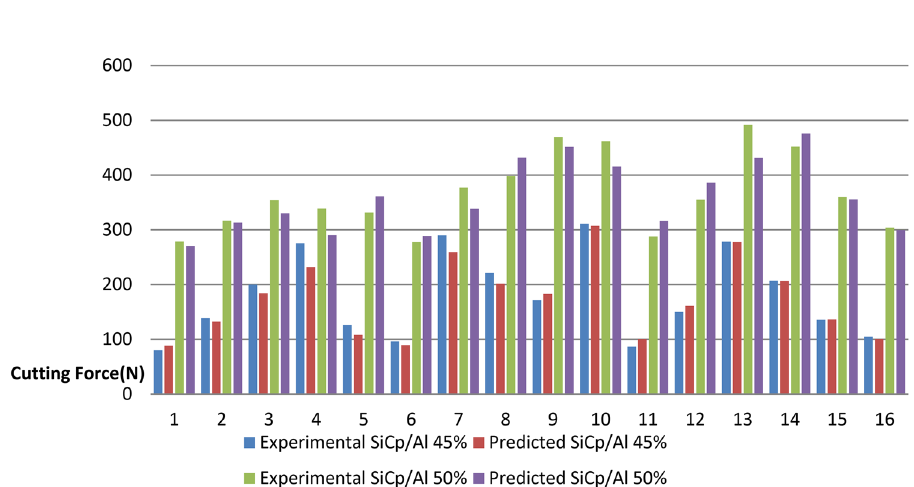
Fig. 26 Comparisons of Error Percentages of Cutting force of F x , and F z of SiCp/Al 45% and